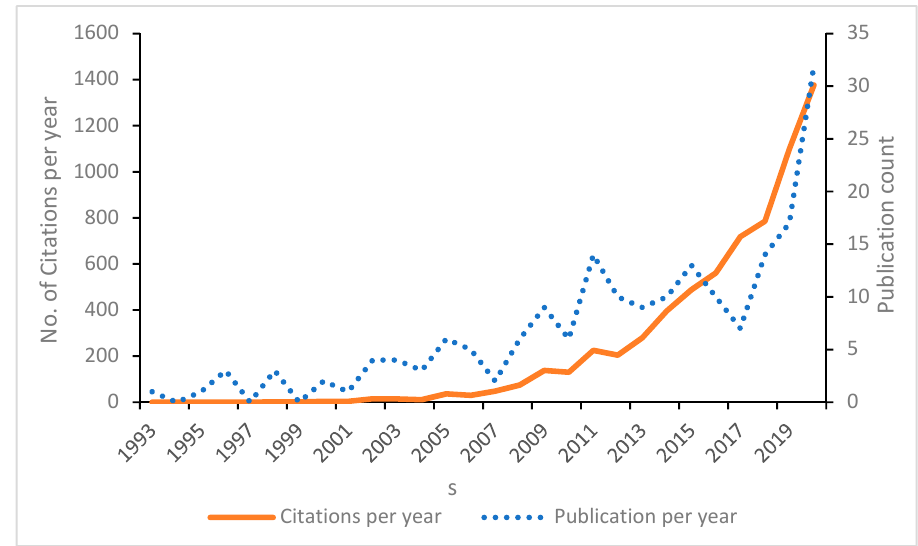
Figure 3. Annual publications and citations based on Web of Science (WoS) core database.